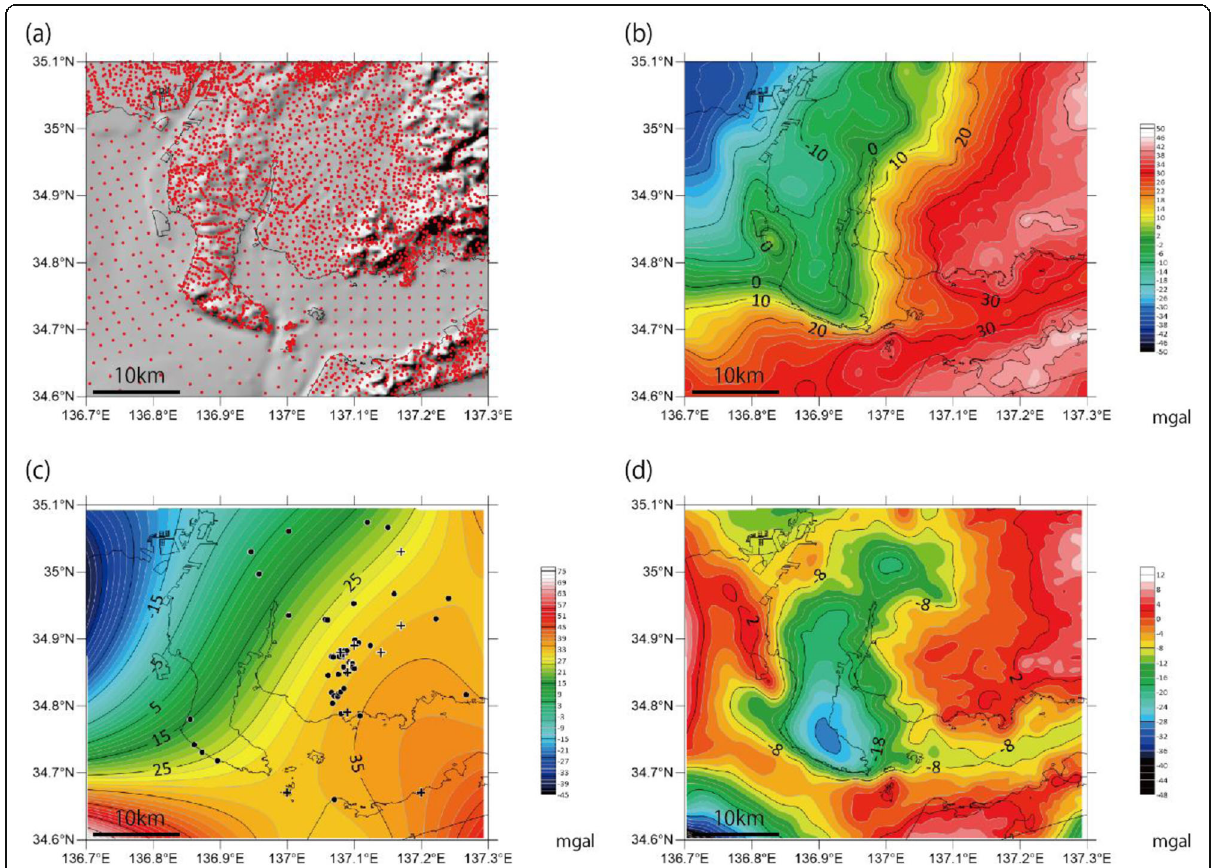
Fig. 3 Bouguer anomaly of the study area. a Red dots indicate the location of gravity stations used for this analysis. b Bouguer anomaly calculated with a reduction density of 2.3 g/cm 3 . c Regional trend of the Bouguer anomaly. Black dots and crosses represent the boring locations and basement exposing locations, respectively. d Residual Bouguer anomaly obtained by deducting the regional trend ( c ) from the original Bouguer anomaly ( b ). The topography ( a ) is illustrated by using the 30 m gridded terrain data compiled by Murata et al.